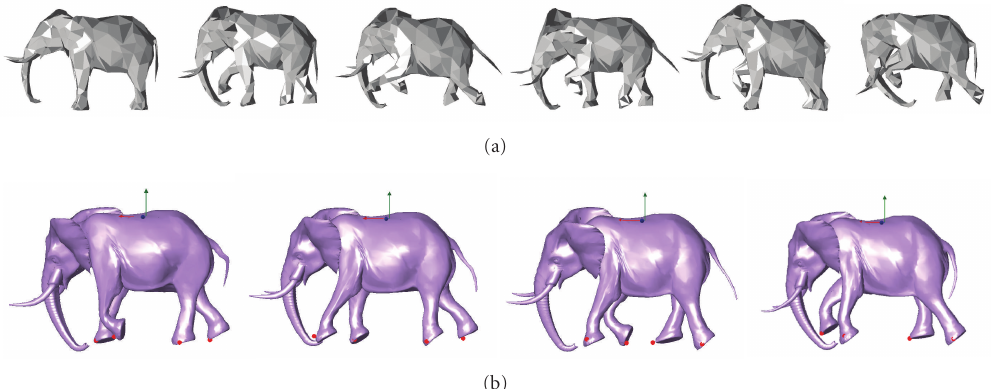
Figure 7: With 6 coarse examples (1k triangles) (a), we can create walking elephant (30k triangles) by translating handles on the feet